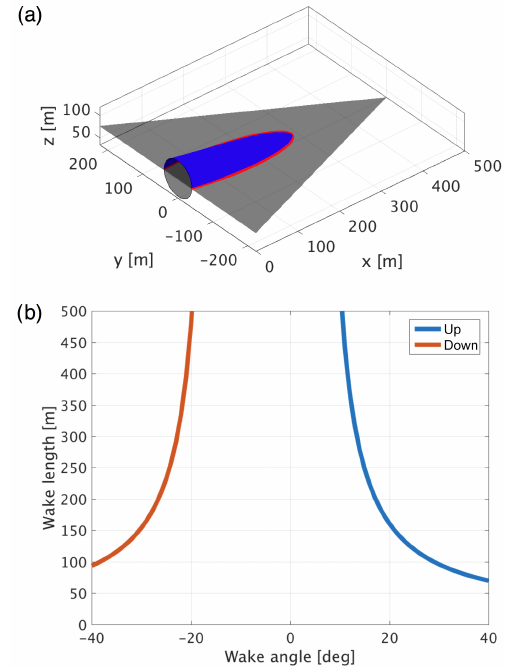
Figure 8. Wake cross section model: (a) model schematic for a negative vertical wake angle of − 23 ◦ (black plane: one half of the diamond scan plane; blue plane: cone section representing the wake; red line: cross section; black circle: rotor plane); (b) derived length of the wake cross section in the diamond scan for different wake angles with a wake expansion angle of (cid:50) = 10 ◦ . The asymmetry of the model results from the negatively inclined scanning